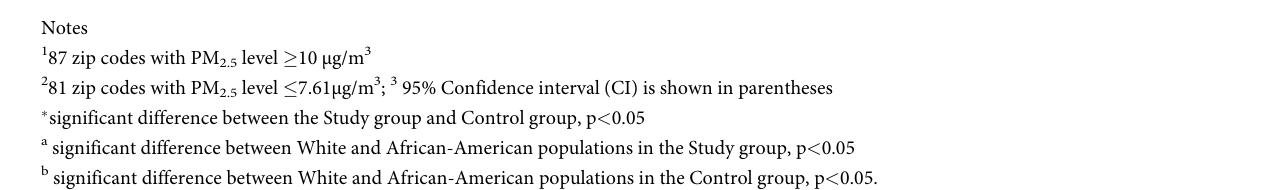
(Table 3): 1.35, 95%CI[1.24–1.48] vs. 0.97, 95%CI[0.90–1.04] and 1.13, 95%CI[0.92–1.31],